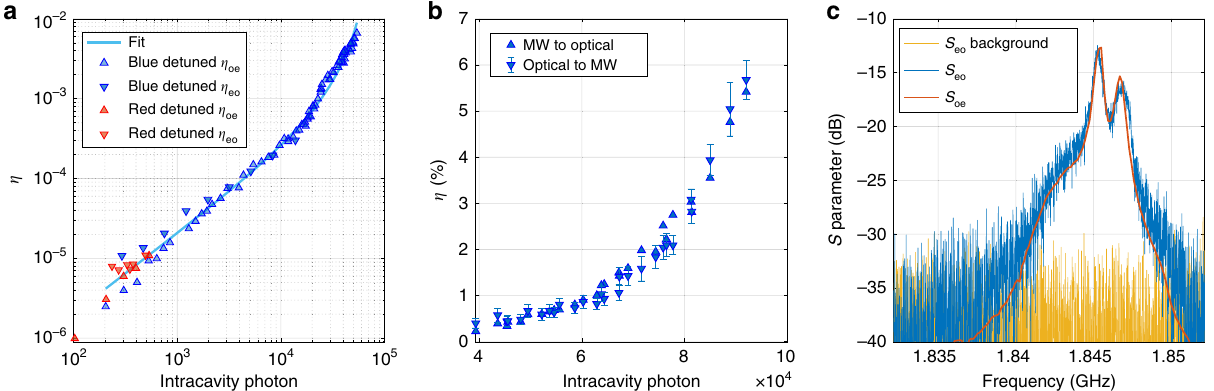
Fig. 4 Bidirectional microwave-optical conversion. a Conversion ef fi ciency measured with red and blue-detuned pump laser. Upward (downward) triangles represent the microwave-to-optical (optical-to-microwave) conversion ef fi ciencies, where the frequency of the photon is upconverted (downconverted). The optical-to-microwave ef fi ciency η blue-detuned pump laser using same measurement setup for η parameter measurement. The maximal j S j 2 is shifted to the calibrated ef fi ciency. The S load instead of the